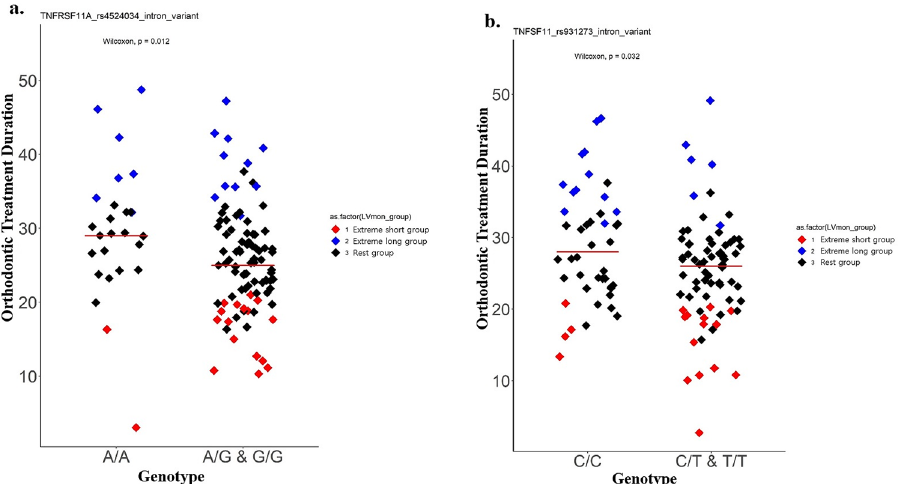
Figure 2. Orthodontic treatment duration according to genotypes in SNPs of TNFRSF11A and TNFSF11. ( a ) TNFRSF11A (rs4524034), ( b ) TNFSF11 (rs931273), A scatter plot illustrating the orthodontic treatment duration in each genotype. The y-axis represents the orthodontic treatment duration values (months) and horizontal bars in the scatter plots represent mean values. Statistical analysis was performed with the Wilcoxon test. *P <